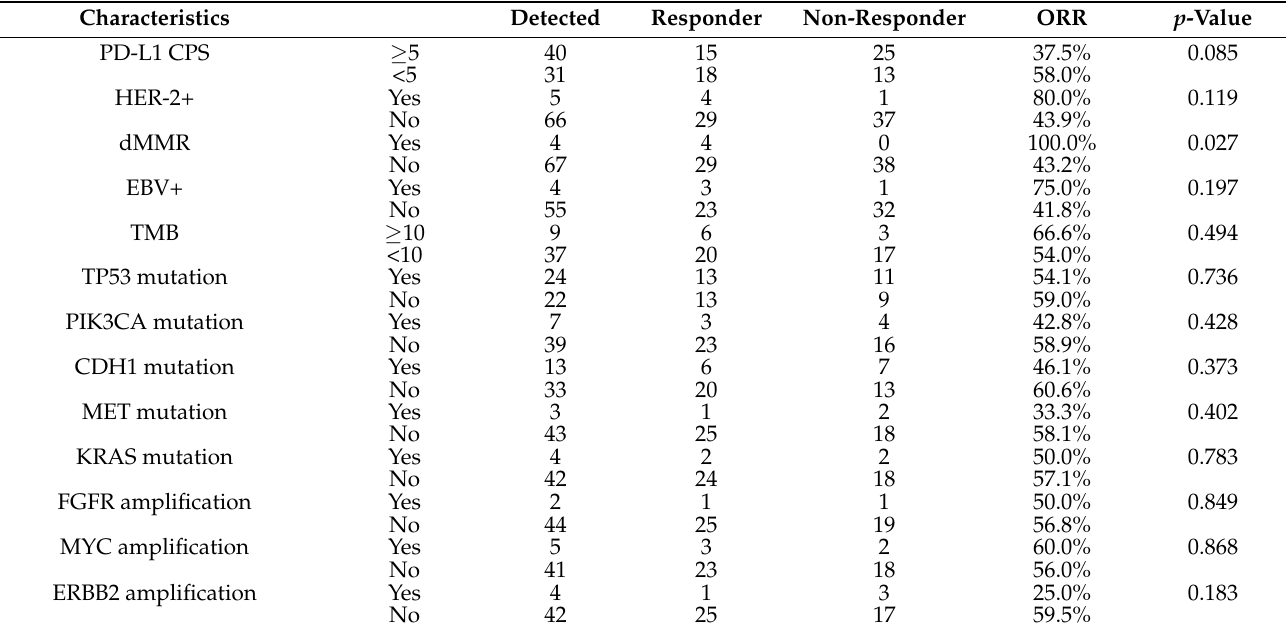
Table 2. Molecular features associated with response to anti-PD-1 therapy in